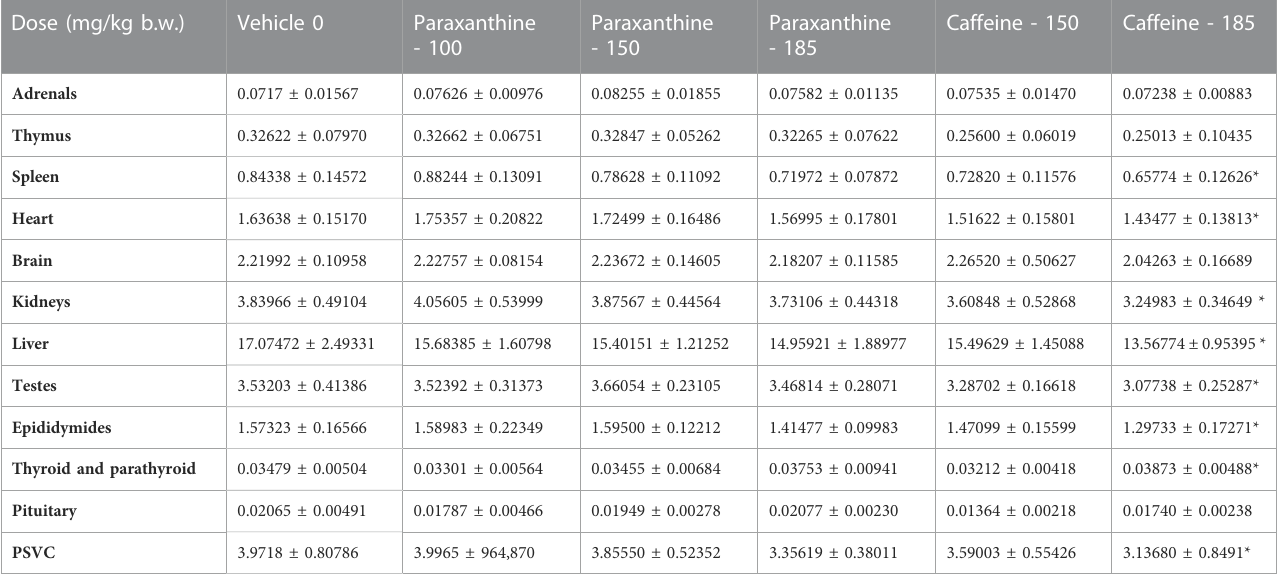
TABLE 6 Summary of absolute organ weights for males in the repeat-dose 90-day toxicity study. Values represent mean ± SD. *Statistically signi fi cant ( p < 0.05) with respect to the vehicle group. Dose (mg/kg b.w.)